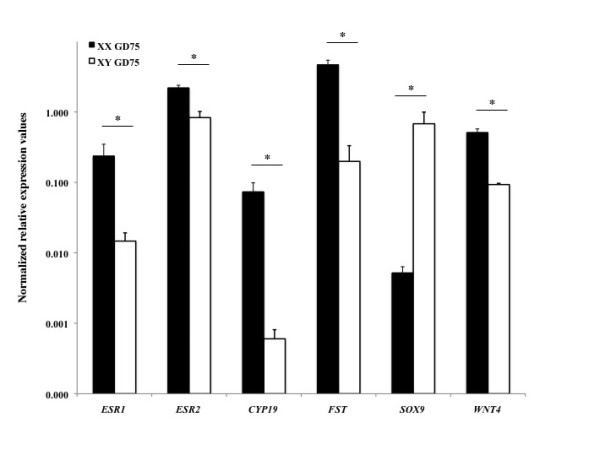
Relative expression level of ESR1, ESR2, CYP19, FST, SOX9, and WNT4 in GD75 ovaries and testes according to real time PCR analysis. ESR1, ESR2, CYP19A1, FST, and WNT4 were significantly (asterisk, P < 0.05) higher expressed in GD75 ovaries, whereas SOX9 was significantly (asterisk, P < 0.05) higher expressed in GD75 testes. The y-axis indicates mean 2-ΔCp values (± SEM) according to Schmittgen and Livak, 2008 [33].